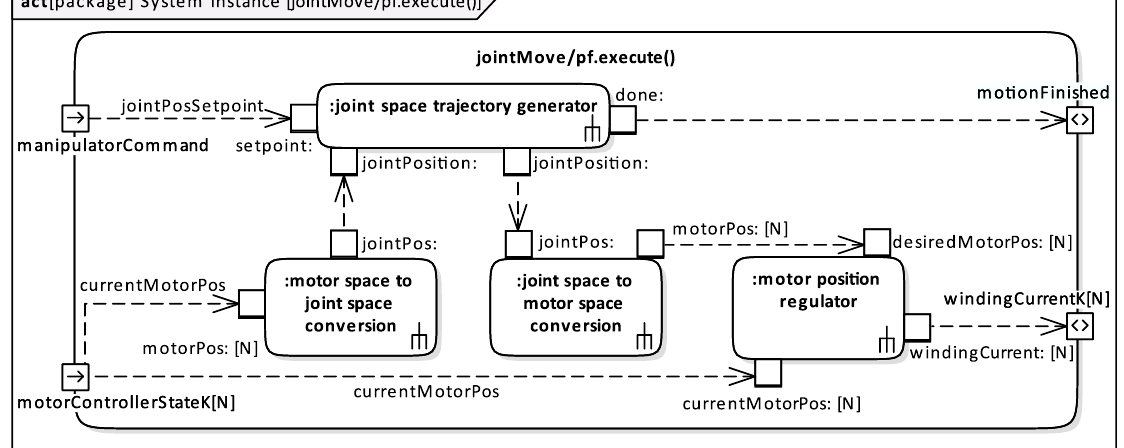
Figure 13. manip / a . cs . jointMove / pf . execute () – operation definition.